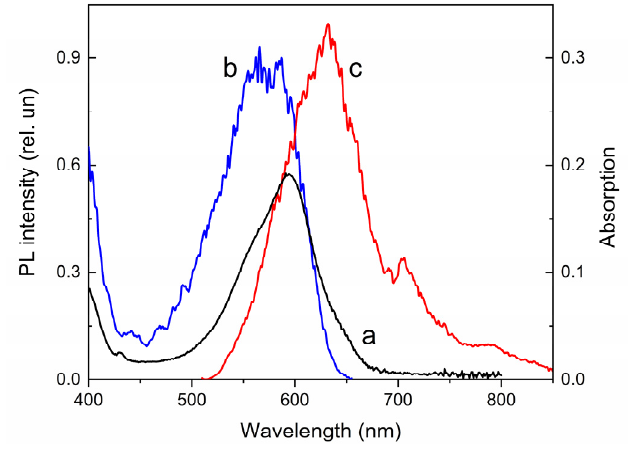
Figure 6. The absorption ( a ), PL excitation ( b ) and PL ( c ) spectra of 2 ′ . λ em = 670 nm (2), λ exc = 490 nm (3), T = 298 K.